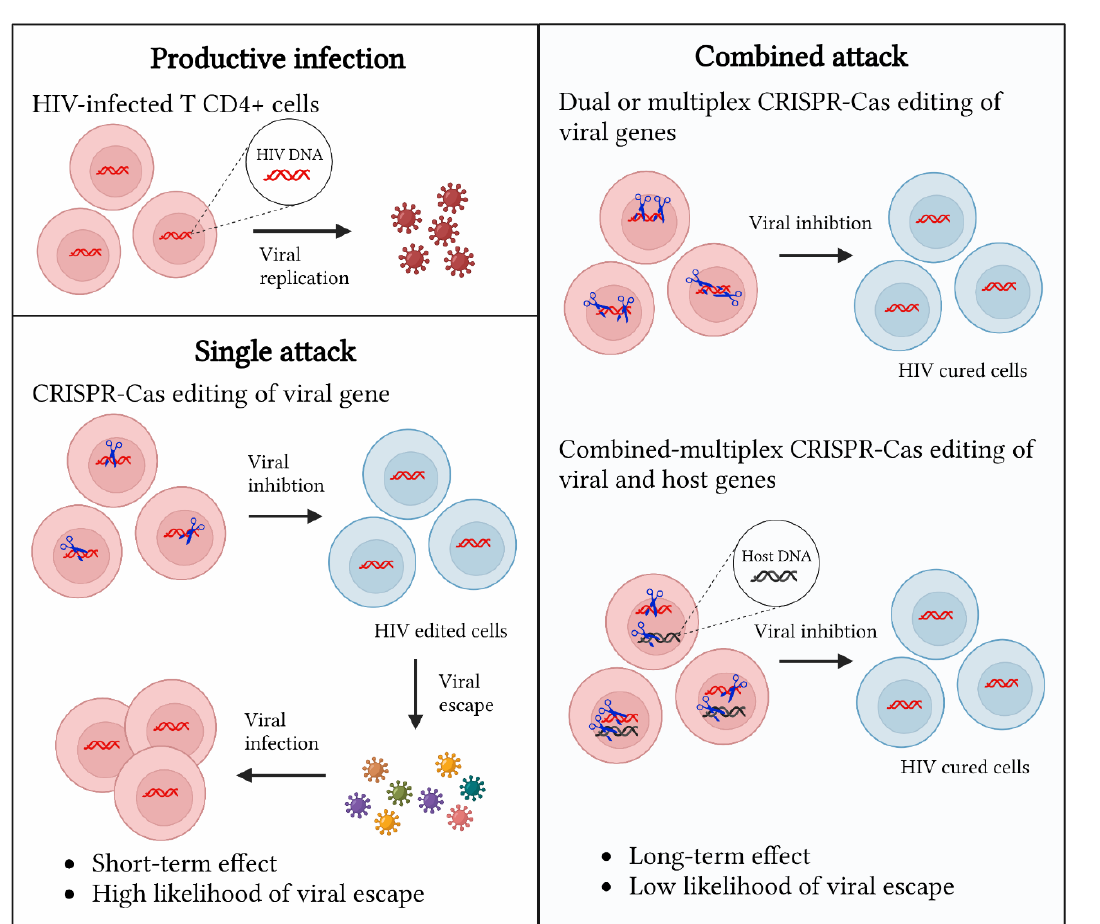
Figure 4. Comparison of CRISPR-Cas editing platforms for gene therapy of HIV infections. CRISPR- Cas editing platforms (blue scissors) against HIV can be classified into three categories: the single targeting of HIV genes, the dual or multiplex targeting of HIV genes, and a combined targeting of HIV genes and host DNA to boost the activity restriction factors.